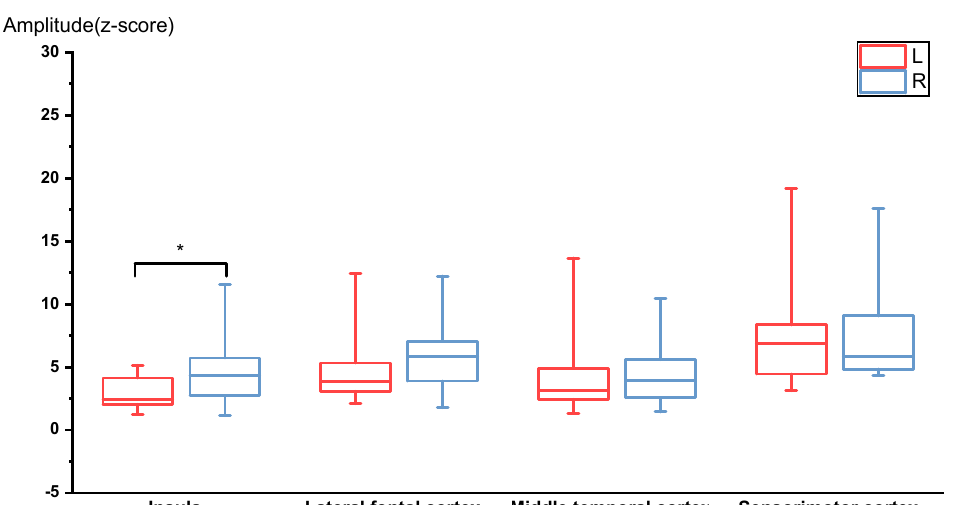
Figure 2. RREF M1 peak amplitudes for the 4 ROIs, including insula, lateral frontal cortex, middle temporal cortex, and sensorimotor cortex (N = 14). The right insula was activated significantly higher compared to the left insula. * p < 0.05.